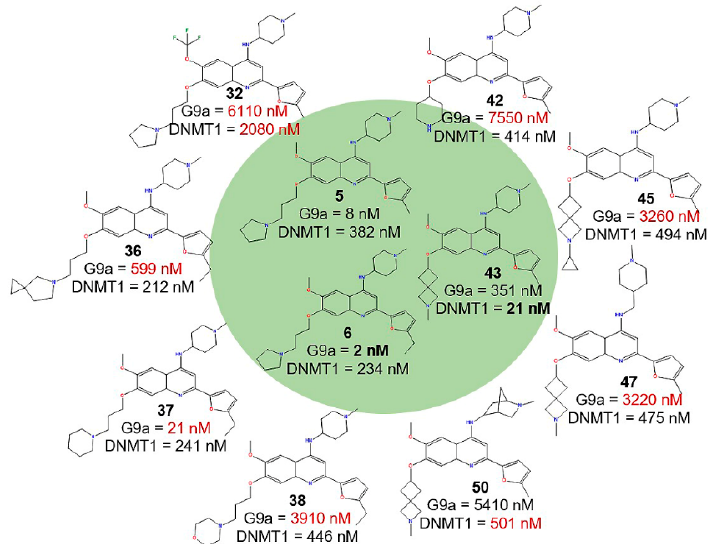
Figure 4. Chemical structures of representative compounds forming activity cliffs.